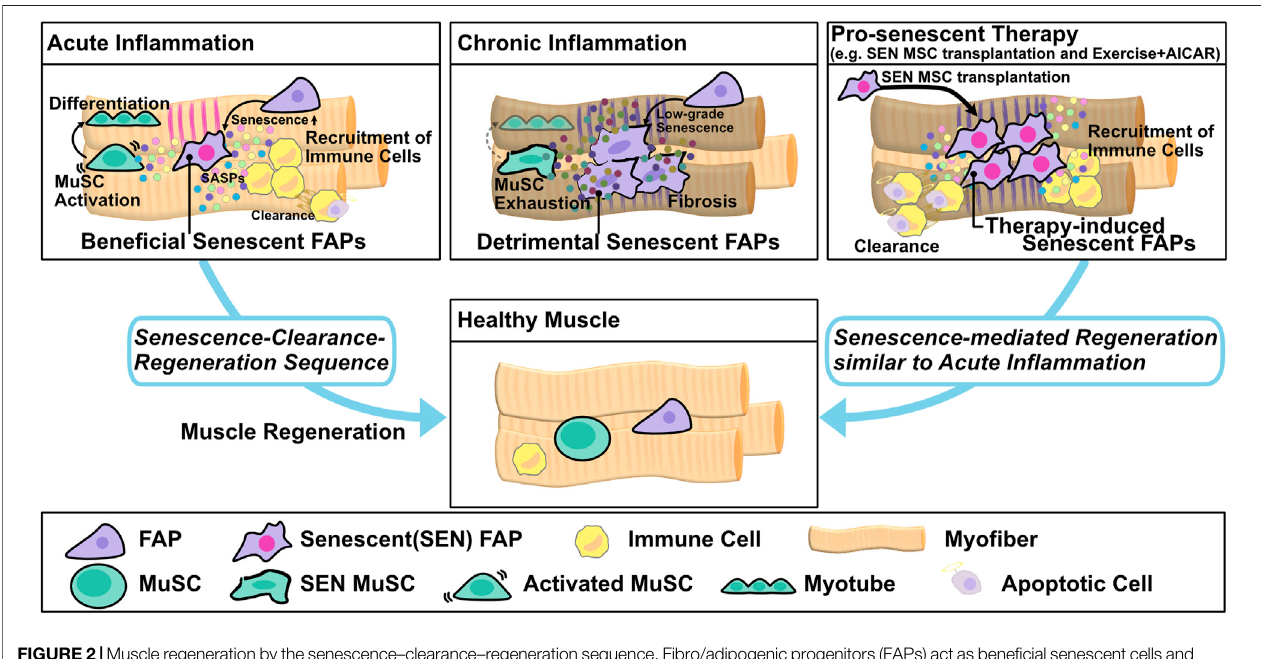
FIGURE2| Muscleregenerationbythesenescence – clearance – regenerationsequence.Fibro/adipogenicprogenitors(FAPs)actasbene fi cialsenescentcellsand express high levels of senescence factors during acute in fl ammation. Bene fi cial senescent cells secrete SASP factors to recruit immune cells and promote muscle stem cell (MuSC) activation and differentiation, and then the senescent FAPs are eliminated by immune cells to complete tissue regeneration (senescence – clearance – regeneration sequence). On the other hand, in chronic in fl ammation, the FAPs produce lower levels of senescence factors than in acute in fl ammationandactasdetrimentalsenescentcells.Pro-senescencetherapy,e.g.,transplantationofsenescentmesenchymalstromalcells(MSC)orthecombinationof exercise and AICAR, induces resident FAP senescence and promotes immune recruitment. Subsequently, the FAPs are cleared by immune cells, and muscle regeneration is completed via the senescence – clearance – regeneration sequence, as seen in acute in fl